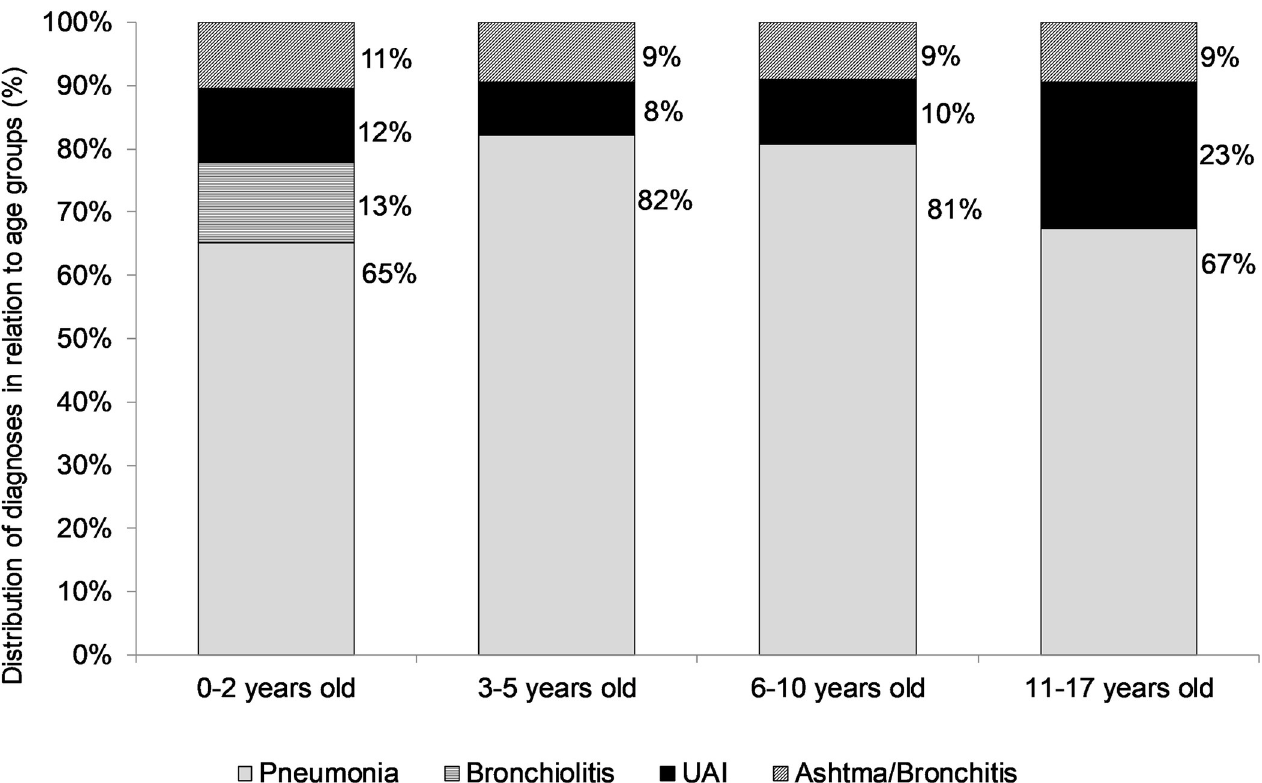
Fig 2. Inpatient diagnoses by age group of pediatric patients admitted for respiratory diseases in the period from January 2015 to June 2020.